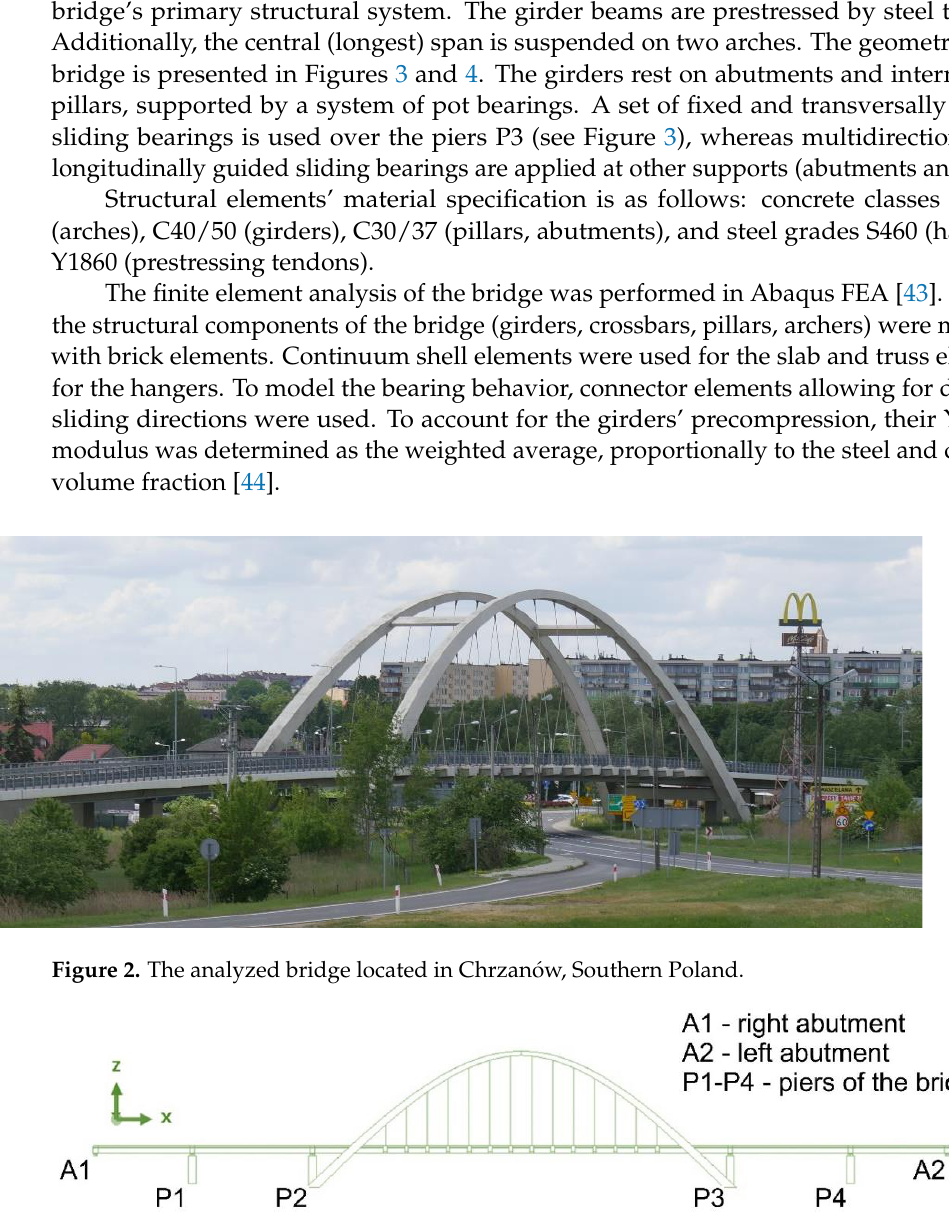
Figure 4. The geometry and main dimensions of the deck cross-section of the bridge [cm]. The finite element analysis of the bridge was performed in Abaqus FEA [43]. Most of the structural components of the bridge (girders, crossbars, pillars, archers) were modeled with brick elements. Continuum shell elements were used for the slab and truss elements for the hangers. To model the bearing behavior, connector elements allowing for different sliding directions were used. To account for the girders’ precompression, their Young’s modulus was determined as the weighted average, proportionally to the steel and con- crete volume fraction [44]. 2.2.2. Theoretical Background and Experimental Set-Up for Apparent Wave Velocity Estimation The apparent wave velocity v is the second parameter of the proposed SMIKE model. It reflects the speed of the wave passage under a multiple-support structure. The wave passage induces non-uniform movements of the structure’s supports, which cause addi- tional stresses in a structure. The stiffer the structure’s subsoil, the higher the apparent wave velocity. The apparent wave velocity can be determined based on the cross-correlation func- tion 𝛹(𝜏) of signals x ( t ) and y ( t ) registered at two different points located in the direction of wave propagation [45,46]: 𝛹(𝜏) = 𝑚𝑎𝑥 𝜏 ∫